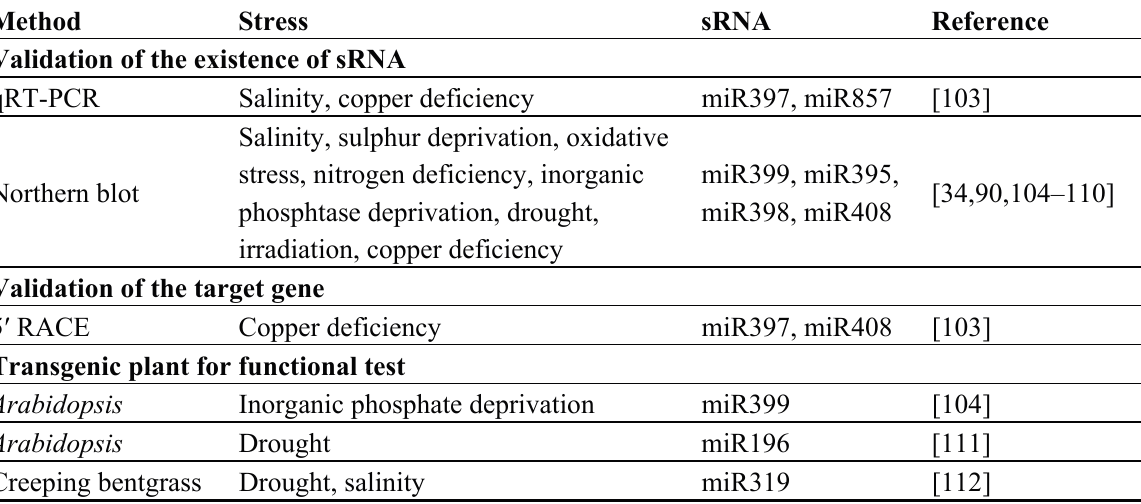
Table 4. Summary of experimental methodologies previously used for sRNA